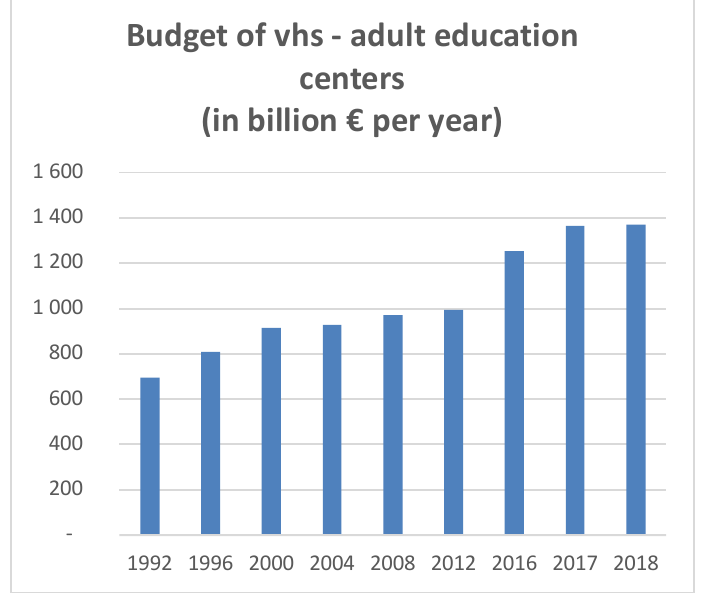
Figure 5. VHS Budget between 1992 and 2018. (Source: dvv-Statistik. Data processing is my